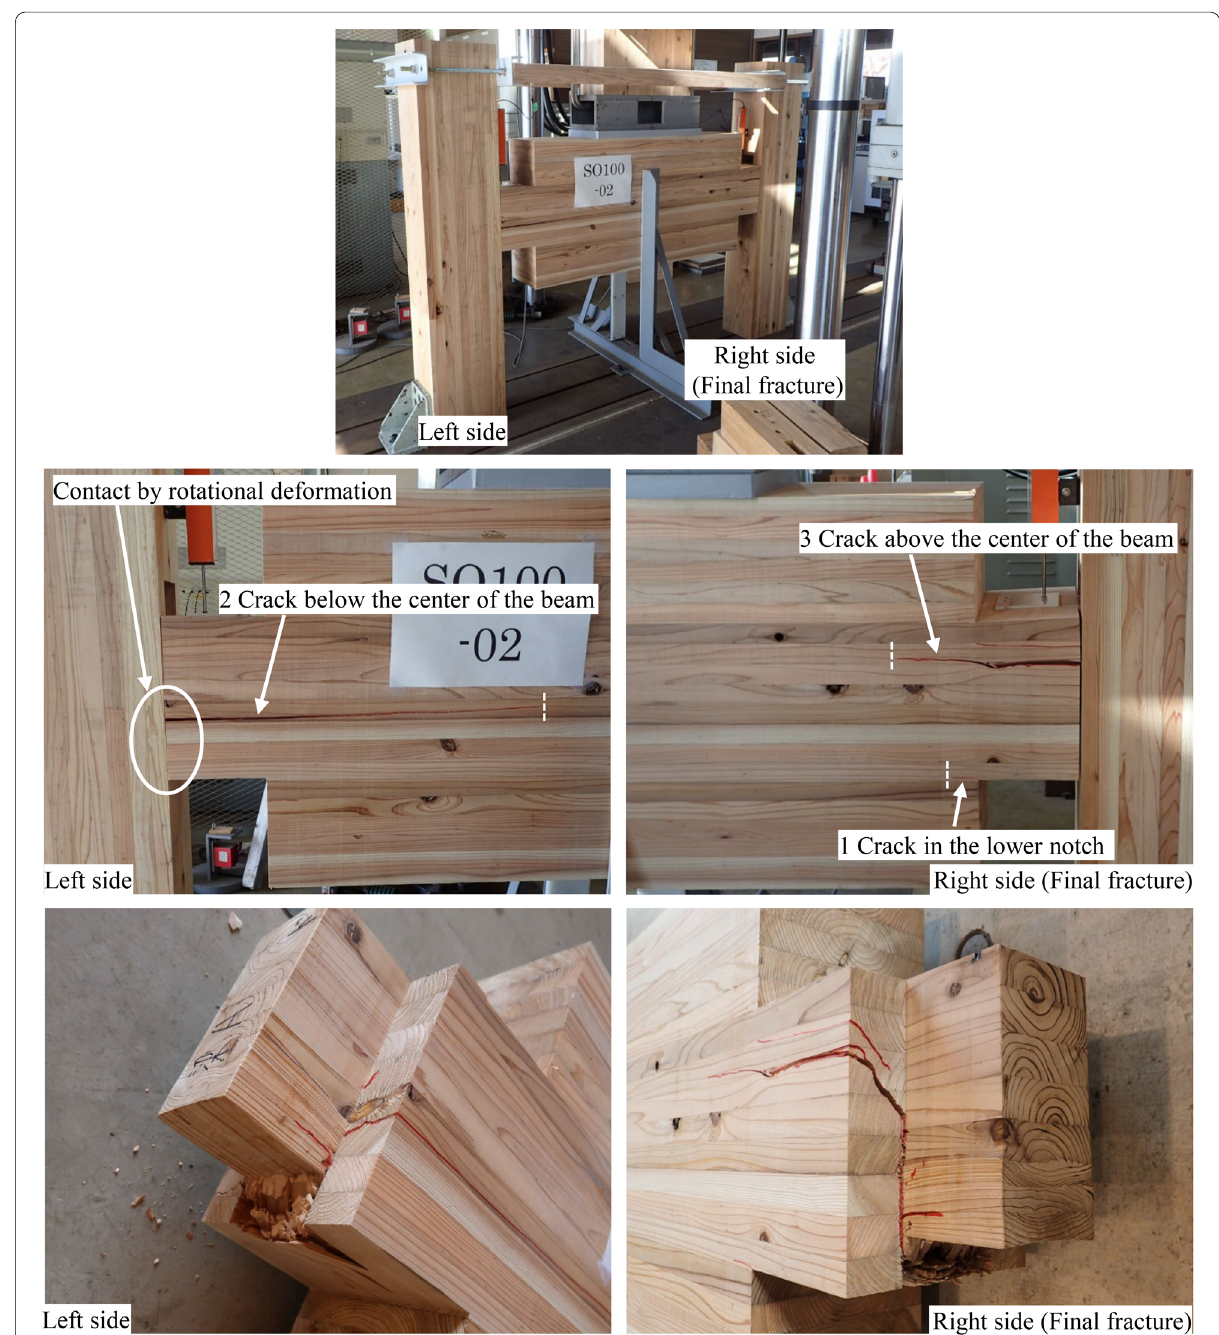
Fig. 11 Final fracture state of the specimen (J-L100, No.